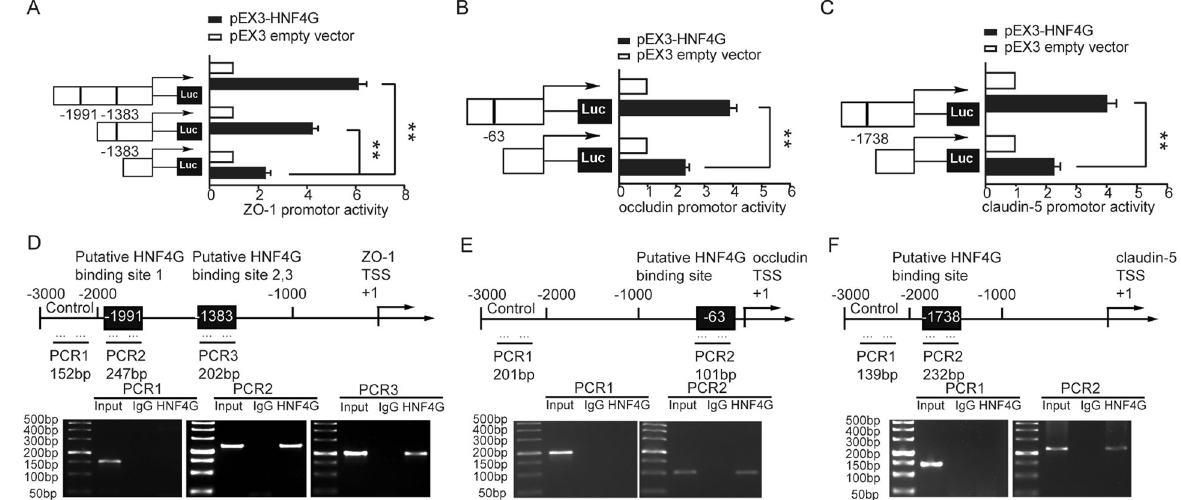
Fig. 7 HNF4G bound to ZO-1, occludin and claudin-5 promoters, and inhibited their expression at the transcriptional level. A – C Schematic diagrams of different reporter plasmids and relative dual-luciferase activities of ZO-1, occludin and claudin-5. The left side showed the deletion sites on the promoters of ZO-1, occludin and claudin-5, and the right side showed the decreases of reporter vector activities after the deletions of the putative binding sites of HNF4G. Data represent means ± SD ( n = 5, each). ** P < 0.01. D – F Schematic representations of ZO-1, occludin and claudin-5 promoter region from TSS to upstream 3000 bp in ChIP assays. TSS was designated as + 1. Immunoprecipitated DNA was ampli fi ed by PCR. Normal rabbit IgG was used as a negative